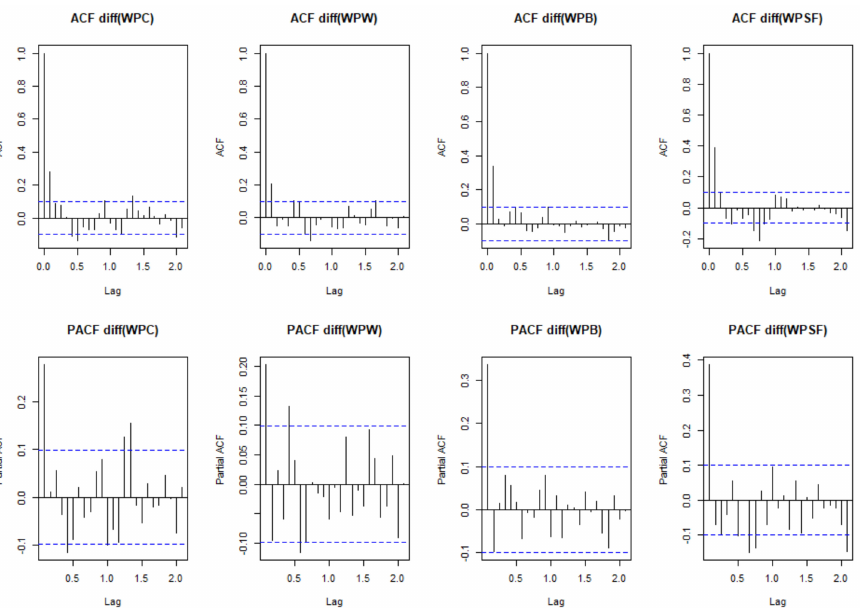
Figure A3. Autocorrelation Function (ACF) and Partial Autocorrelation Function (PACF) with differenced